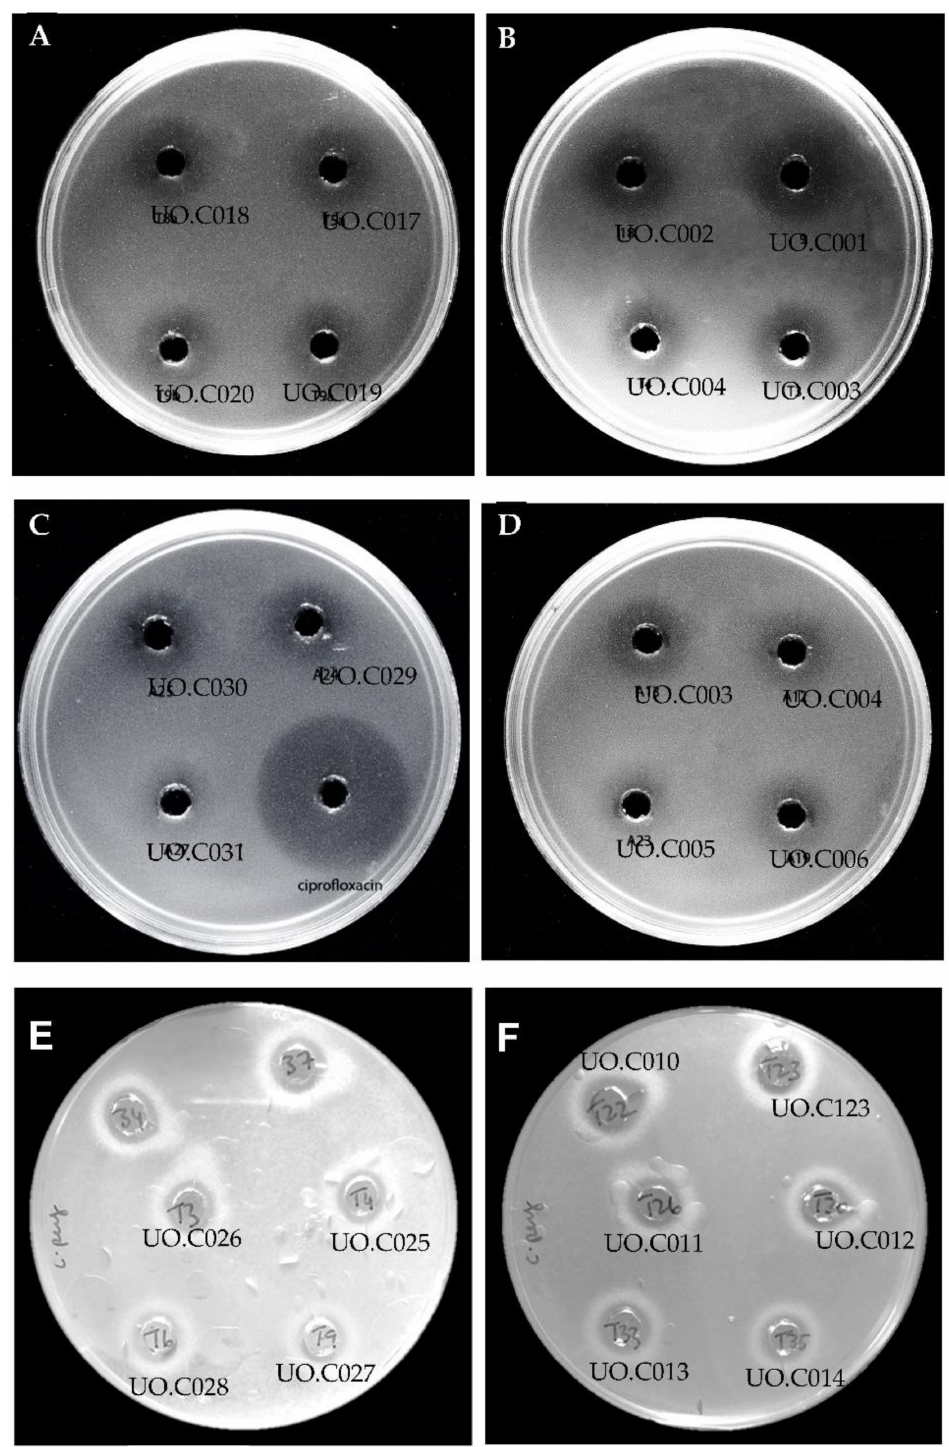
Figure 1. Agar well diffusion assay illustrating the growth inhibition of Salmonella Ty- phimurium ATCC 14028 ( A – D ) and Clostridium perfringens ATCC 13124 ( E , F ) by cell-free supernatants extracted from the isolated